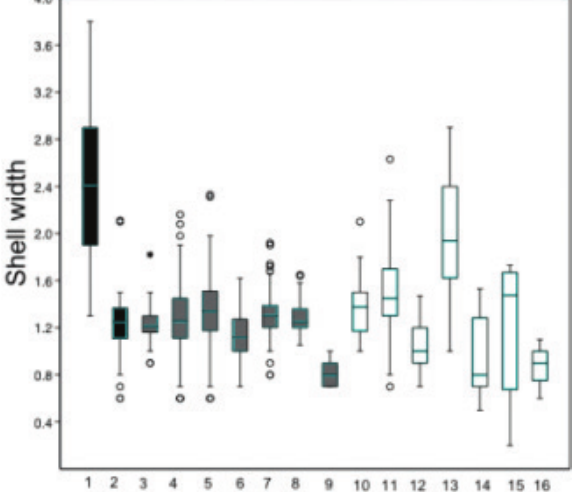
Figure 10. Boxplots showing shell widths on Potamolithus spp. Horizontal Bar, median; vertical bar, whiskers with minimal and maximum observations. 1 P. ribeirensis 2 Potamolithus sp. 1 3 P. karsticus 4 Potamolithus sp. 2 5 Potamolithus sp. 3 6 Potamolithus sp. 4 7 Potamolithus sp. 5 8 Potamolithus sp. 6 9 Potamolithus sp. 7 10 P. troglobius 11 Potamolithus aff. t roglobius 12 Potamolithus sp. 8 13 Potamolithus sp. 9 14 Potamolithus sp. 10 15 Potamolithus sp. 11 16 Potamolithus sp. 12. Black bars, epigean species; gray bars, troglophilic species; white bars, troglobitic species; circles, outliers; *,